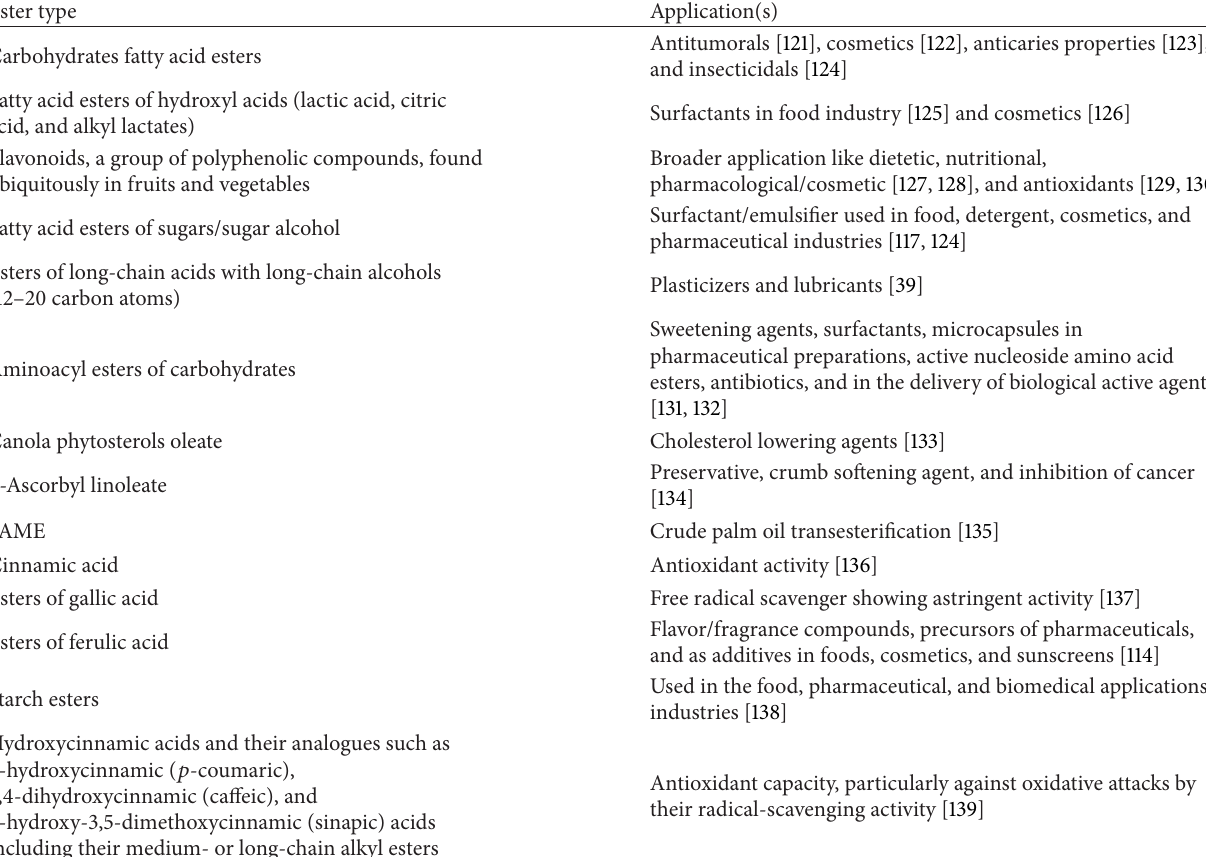
Table 3: Broader applications of fatty acid